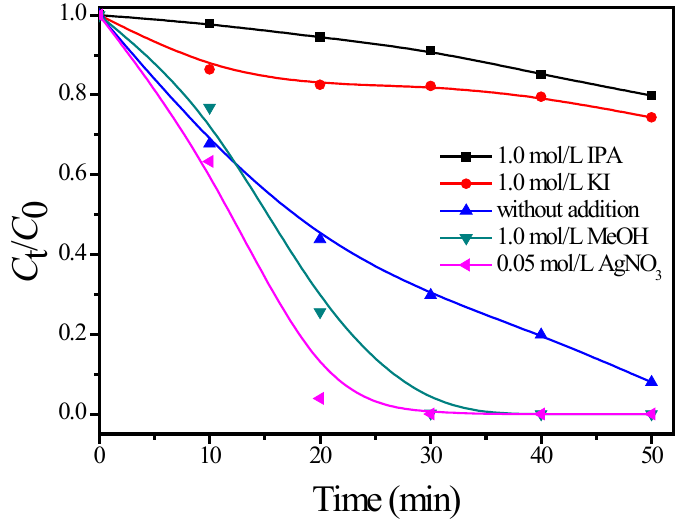
Figure 7. Effects of various reactive species scavengers on the photodegradation of MO by pigment P1.